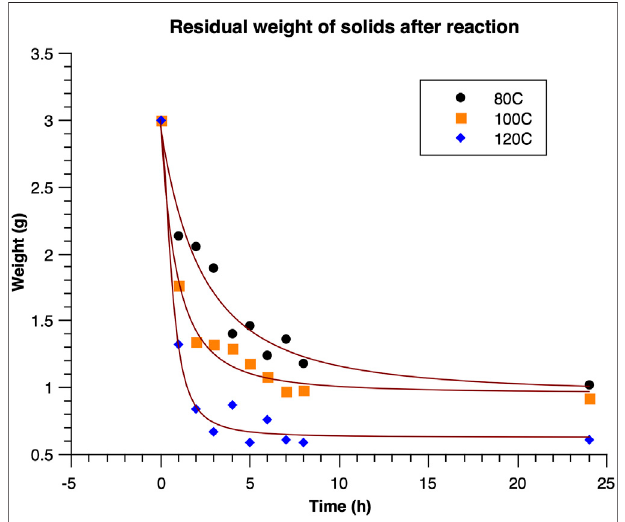
FIGURE 2 | Residual carbon in solids ( fi tted curves are provided for visualization purposes